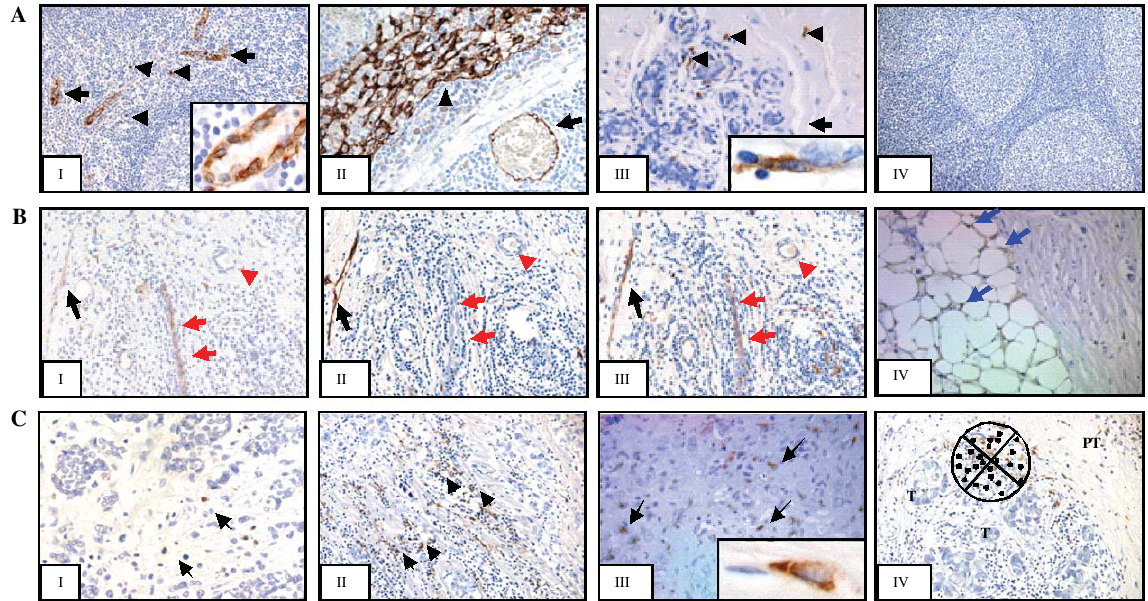
Fig. 2. (A) CLEVER-1 expression in FFPE specimens of tonsil (I), LN (II), and normal breast tissue (III). Strong CLEVER-1 staining is detected in tonsils and in LN endothelial cells of lymphatics/HEV (black arrows). Strong expression is also found in M (cid:1) /DC (arrow heads). In normal breast tissues, occasional M (cid:1) /DC staining with CLEVER-1 is observed but no staining in vessels is found ( × 400). An example of negative control staining in a tonsil section is shown in (IV) ( × 200). (B) CLEVER-1 expression in breast cancer. Parallel sections were stained with CLEVER-1 (I), podoplanin (II) and CD34 (III). CLEVER-1 was detected in both blood vessels (CD34 + /podoplanin − , red/grey arrows) and lymph vessels (CD34 ± /podoplanin + , black arrows). CLEVER-1 expression in vessels was variable; an example is shown where positive (red/grey arrows) and negative (arrow heads) blood vessels are present in the same section. Panel IV shows CLEVER-1 positive staining of adipocytes in the tumor periphery (blue/white arrows) × 200. (C) Leukocyte immunohistochemistry in breast cancer. Panels I, II and III show mDC (CD83+ve), iDC (CD209+ve) and M (cid:1) (CD68+ve) leukocytes, respectively. iDC and M (cid:1) were more frequent in the tumor periphery but were also found infiltrating the tumor sheets, as mentioned in the narrative very few mDC were observed. Panel IV shows a representation of a hotspot assessment, used for determination of the iDC index. I–III × 400, IV ×